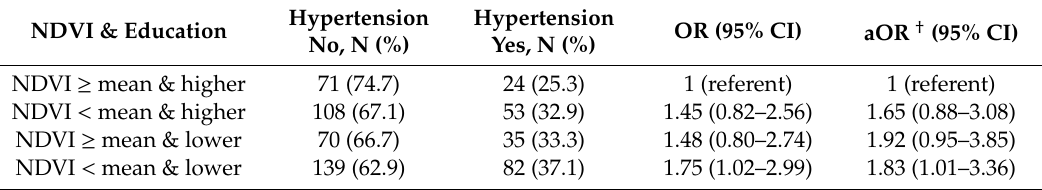
Table 5. Relationships between SES, exposure to greenness (NDVI), and the risk of hypertension. NDVI &